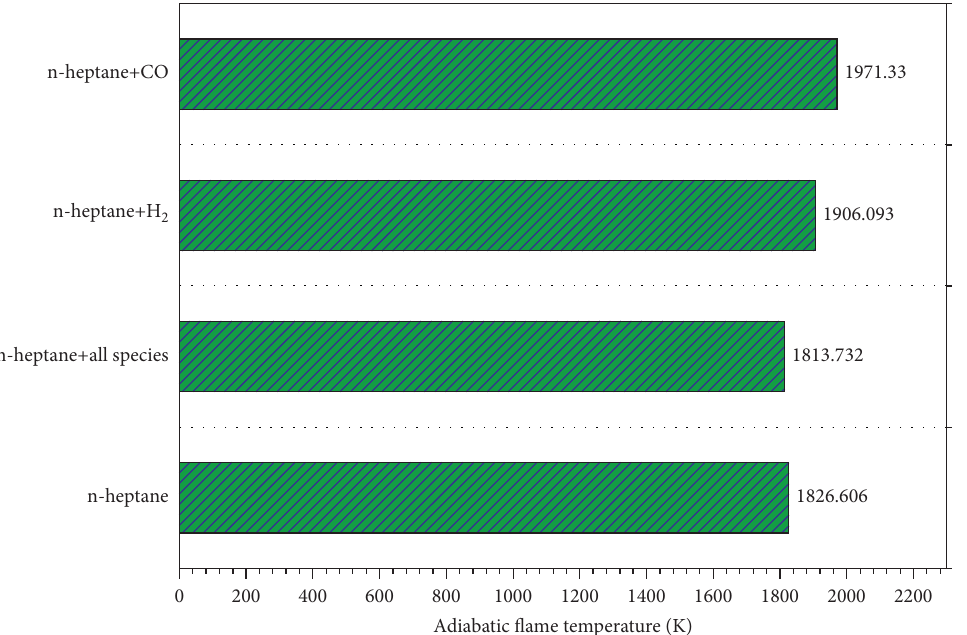
Figure 12: Adiabatic flame temperature of mixtures of different reforming species and n-heptane.